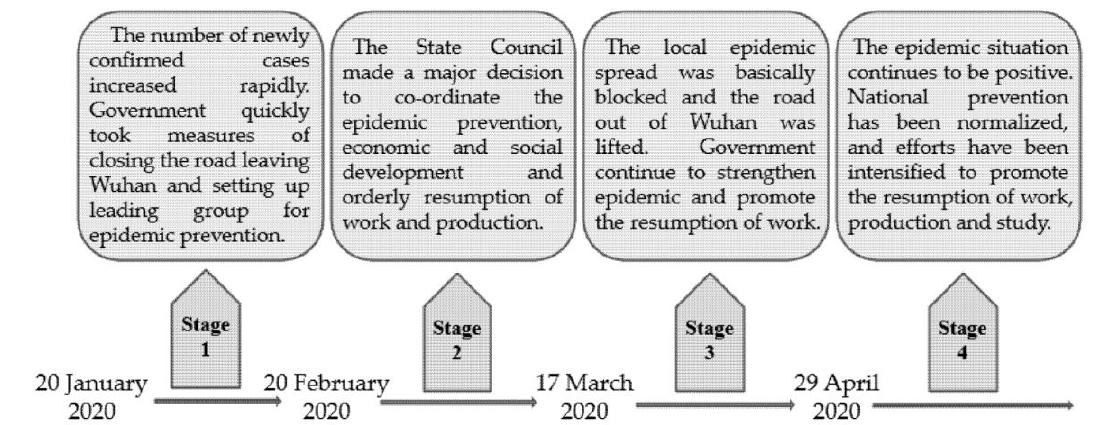
Figure 2. Four stages of managing the COVID-19 pandemic in